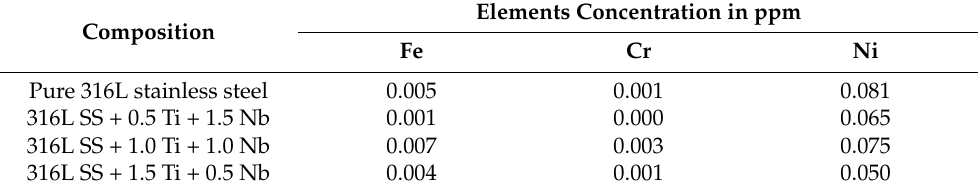
Table 7. Concentration of ions released.